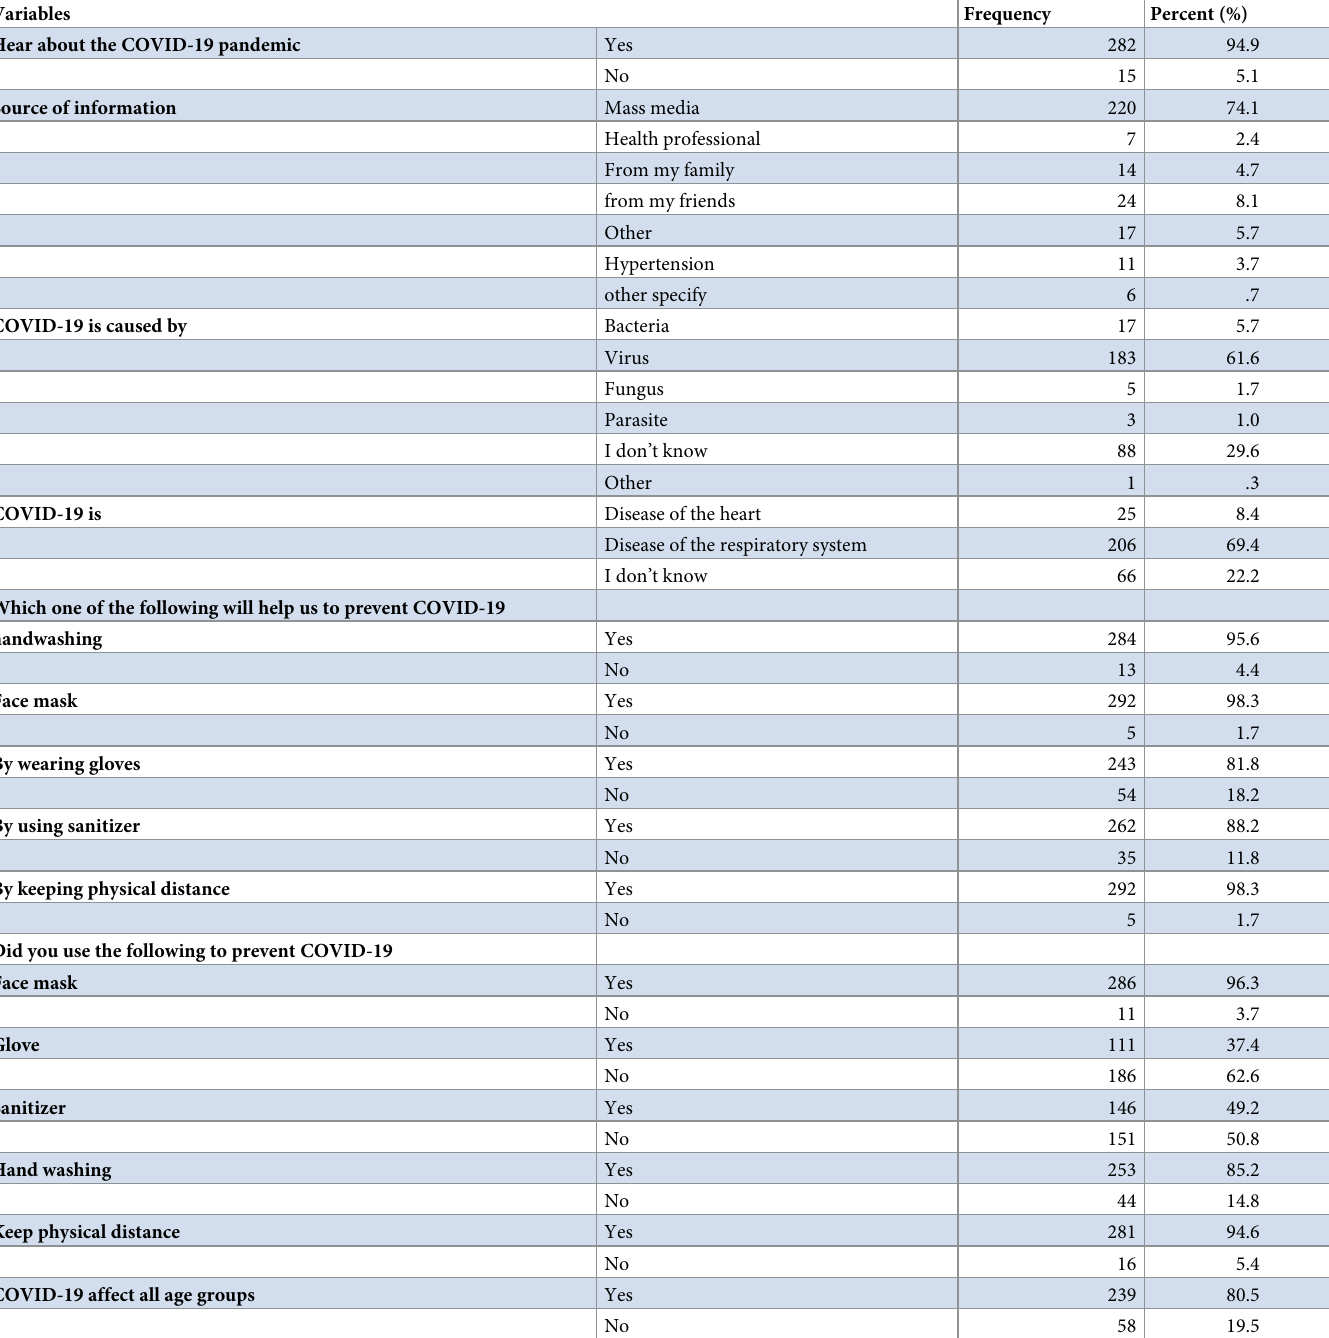
Table 3. COVID-19 related awareness and PPE utilization behavior of the study participants in at quarantine centers, in Addis Ababa, Ethiopia, 2020.